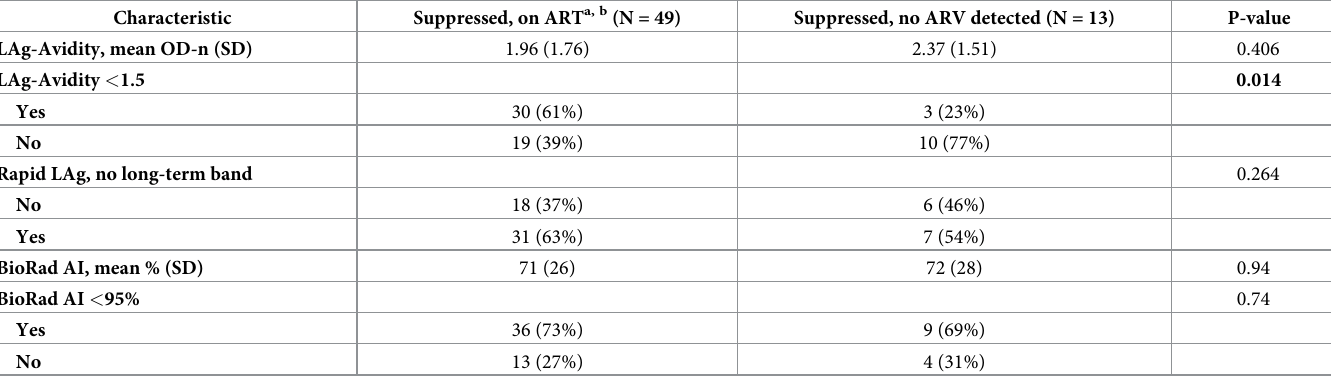
The table compares results obtained with the LAg-Avidity assay, Rapid Lag assay, and BioRad-Avidity assay for seroconverters who were virally suppressed on ART vs. seroconverters with natural viral suppression. a Viral suppression was defined as having a viral load � 400 copies/mL. b Laboratory detection of one or more ARV drugs was considered to be indicative of